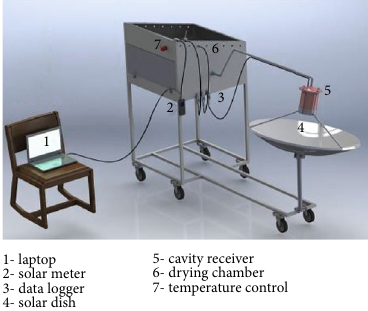
Figure 4: Schematic drawing of experimental